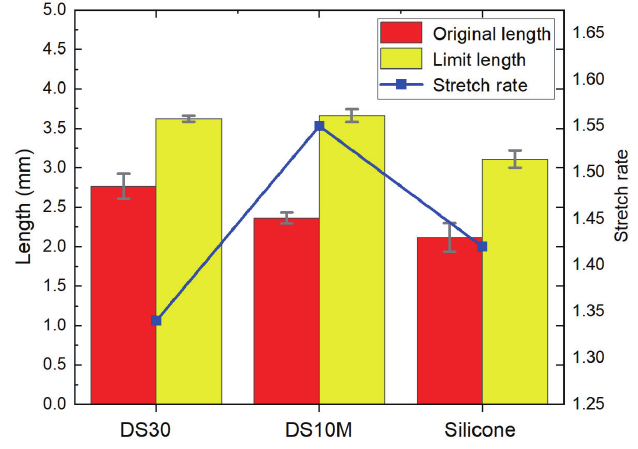
Figure 3. Test results of three types of materials. In the histogram, error bars compare the properties before and after stretching.